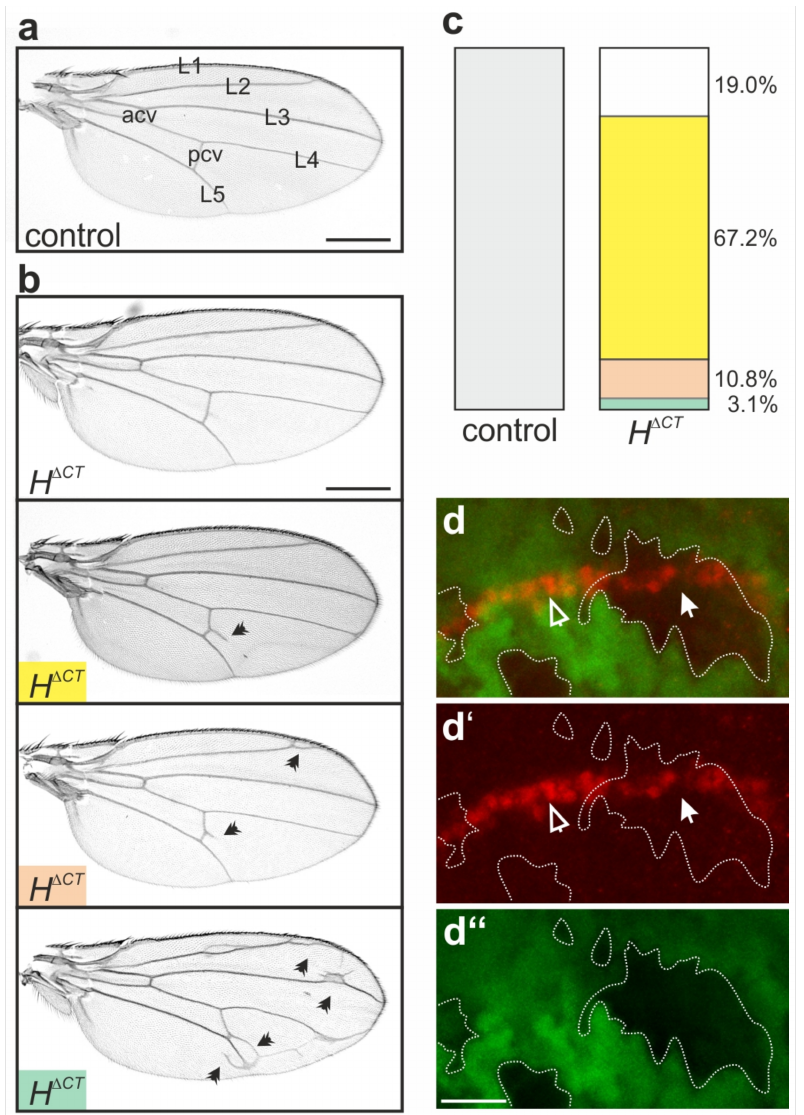
Figure 3. Wing defects in homozygous H ∆ CT flies. ( a ) Wing from control y 1 w 67c23 female fly. Note the typical five longitudinal veins (L1–L5) and the anterior and posterior cross-veins (acv, pcv),